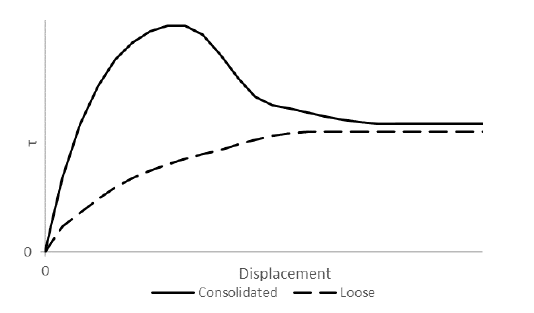
Figure 1. Diagram of box shear